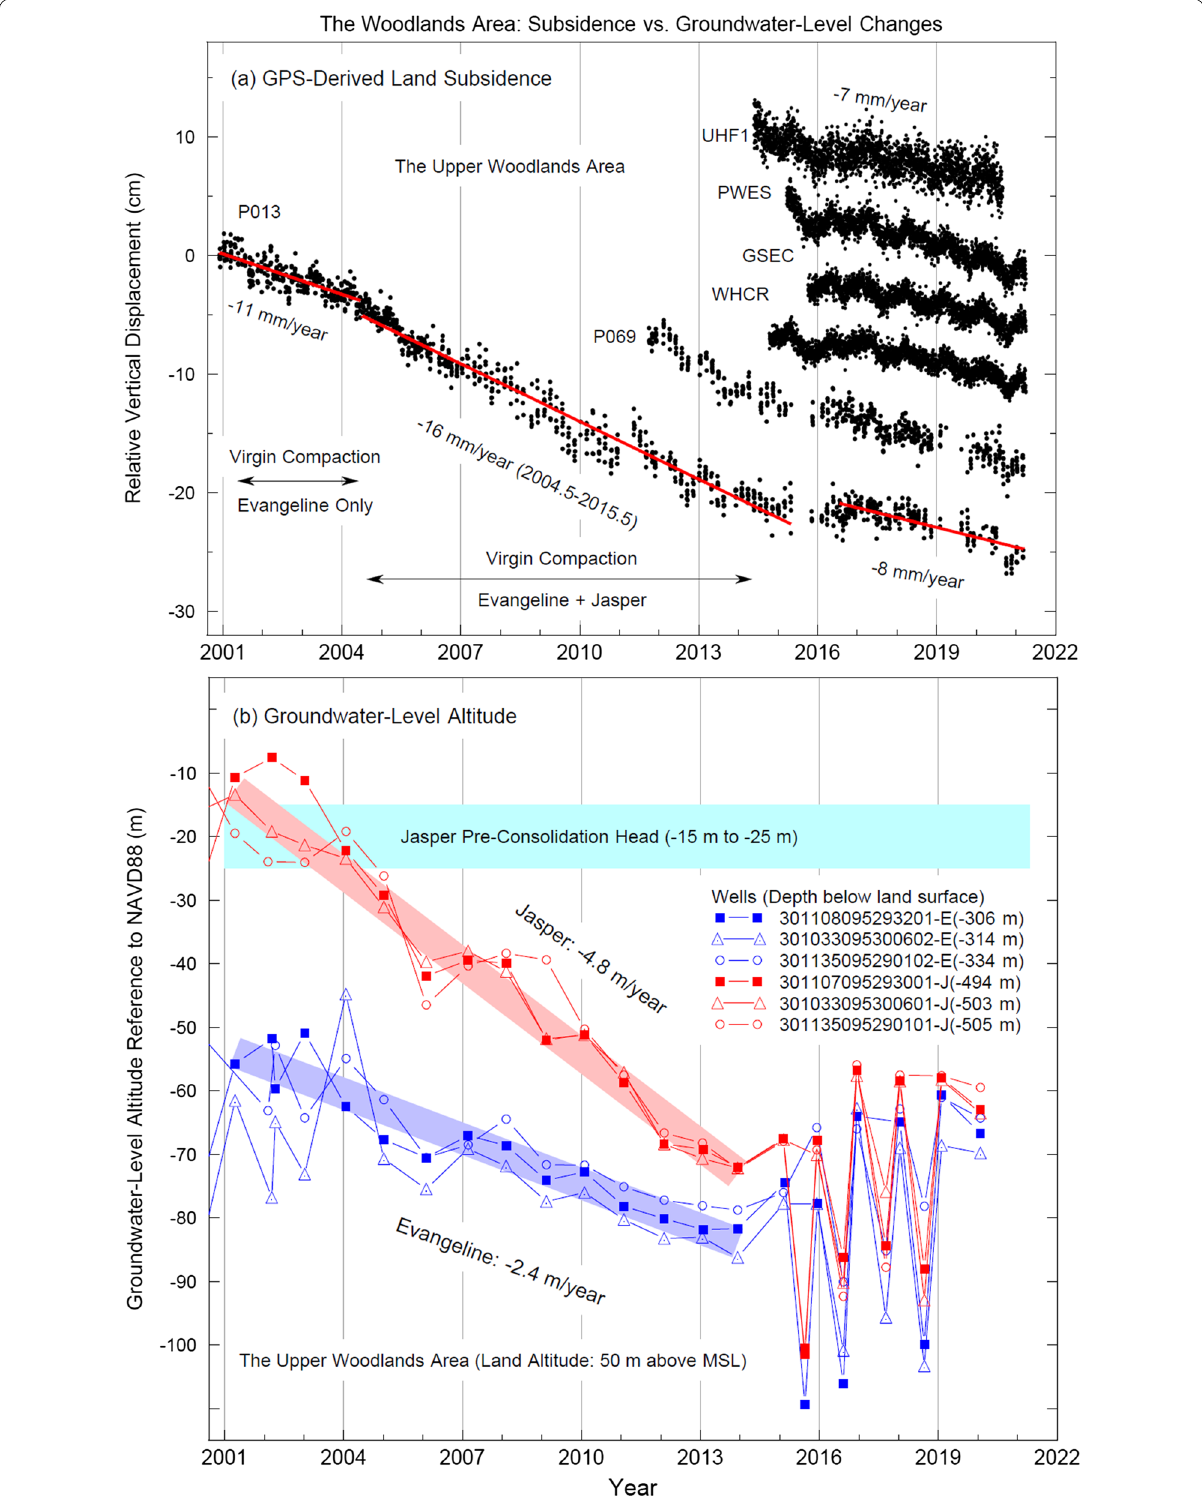
Fig. 13 GPS-derived subsidence and groundwater levels in The Woodland area. The locations of these wells and GPS are marked in Fig.